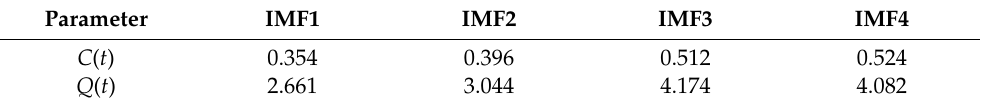
Figure 27. VMD decomposition result. Table 7. The correlation coefficient and kurtosis between IMFand original signal